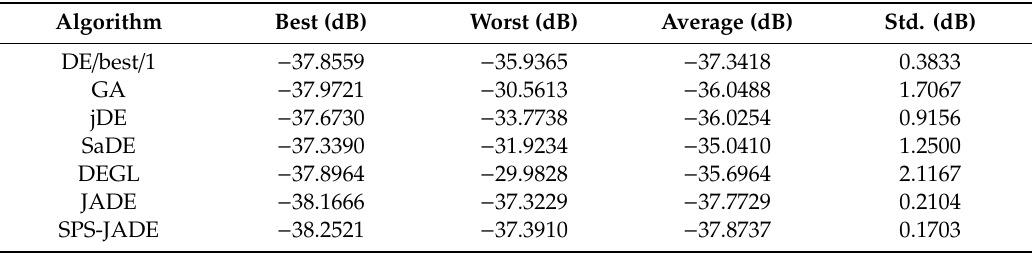
Table 4. Synthesis results of the normalized MSLs for the linear antenna array with sidelobe suppression and null depth.